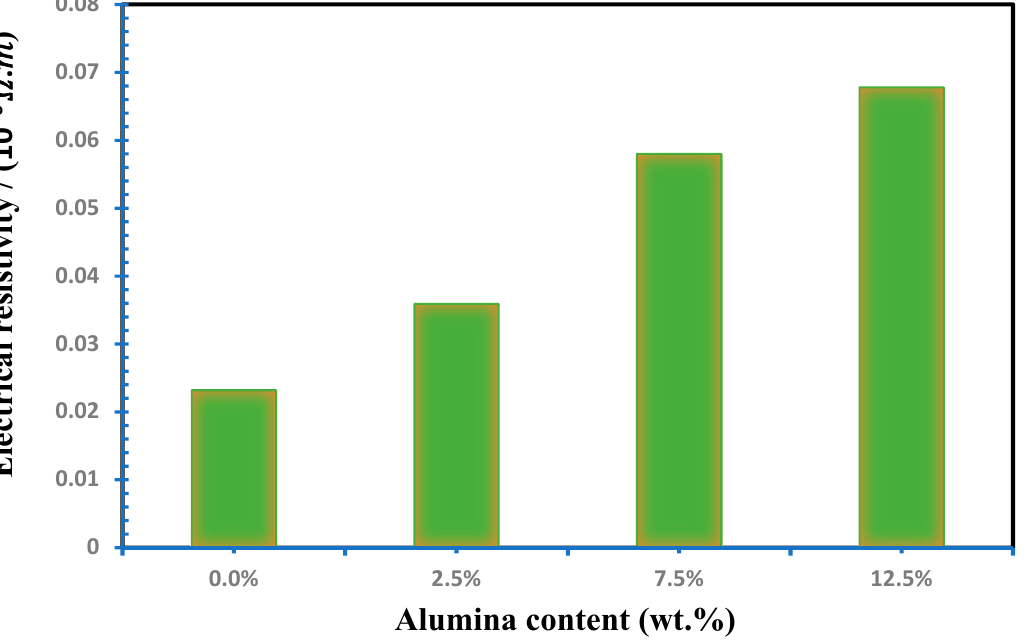
Figure 7. Influence of Al 2 O 3 contents on electrical resistivity of Cu-Al 2 O 3 nanocomposites.